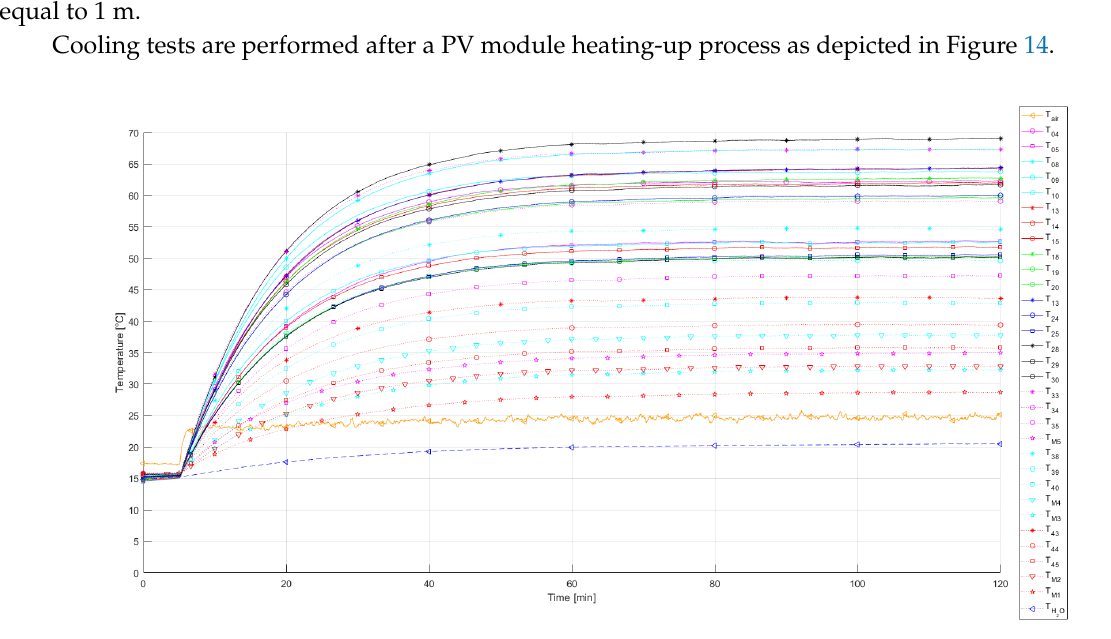
Figure 14. PV module heating-up process. Temperature trends of air, water, and PV module points during heating